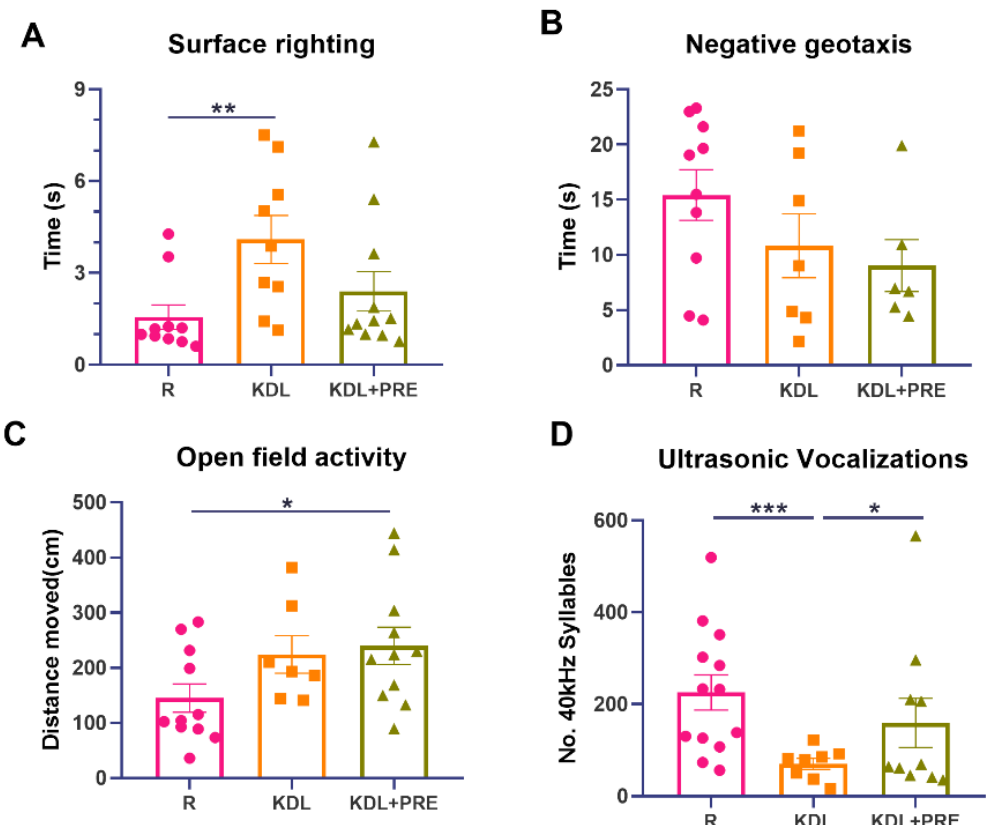
Figure 2. Developmental milestones and communication measurements. ( A ) Surface righting times. ( B ) Negative geotaxis activity. ( C ) Open field activity. ( D ) Ultrasonic vocalizations. R-normally developing reference group; KDL-ketogenic diet formula; KDL+PRE-ketogenic diet formula plus prebiotic fiber. Data are presented as mean ± SEM with individual values. n = 6-13 rats/group. * p < 0.05, ** p < 0.01, *** p < 0.001.